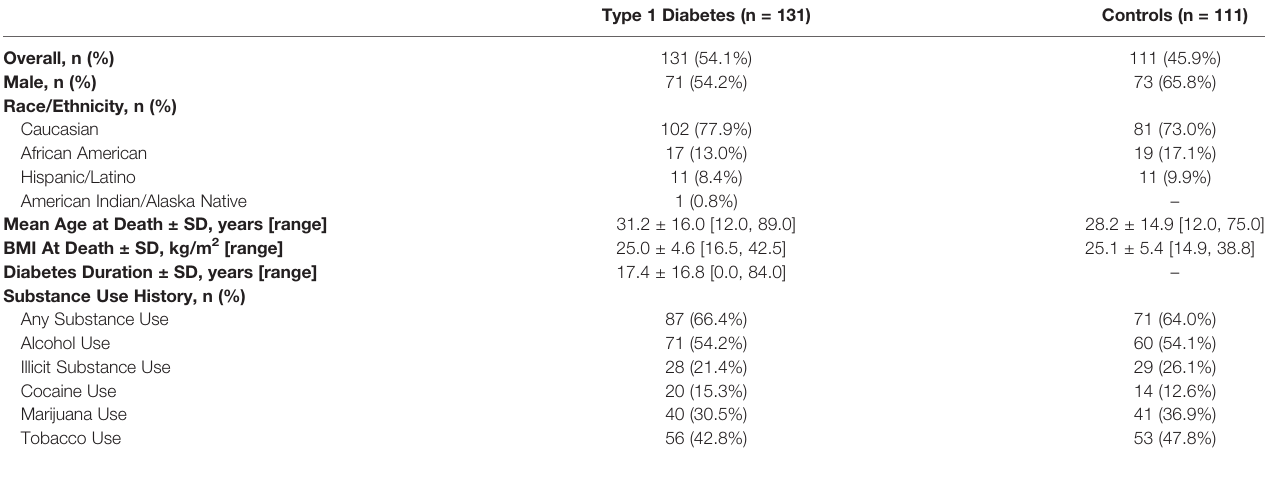
TABLE 1 | Demographics and substance use